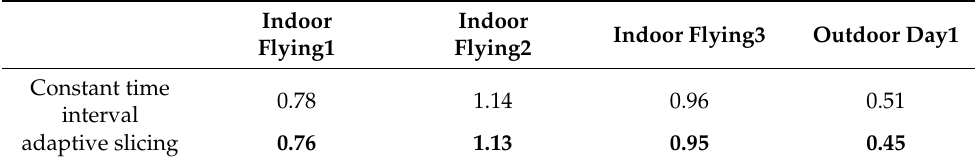
Table 3. Optical flow prediction results obtained by different slicing